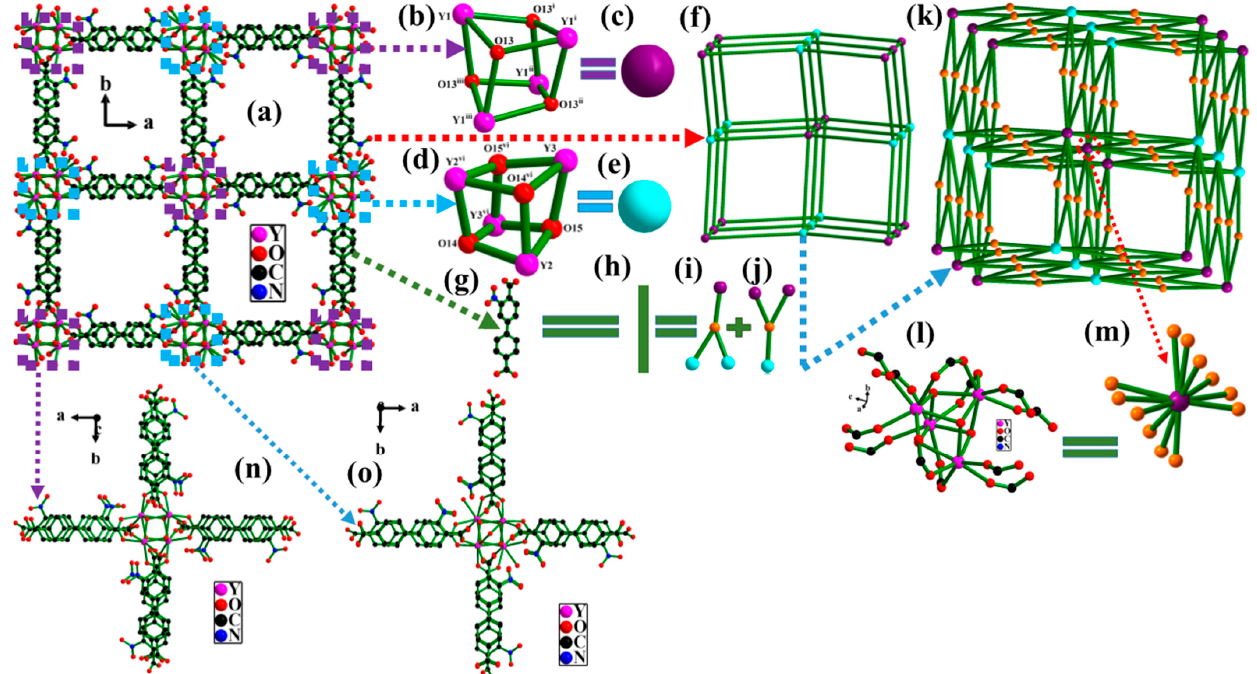
Figure 5. ( a – o ). The simplified schematic diagram of 6-connected pcu net with a Schläfli symbol {4 12 ·6 3 } or 12-connected Au 4 Ho topology with a point (Schläfli) symbol {4 20 ·6 28 ·8 18 }{4 3 } 4 . Topologically, if each {Y 4 O 4 } core serves as a 12-connected node and is linked by 12 nba 2 − ligands, and each nba 2 − chelates or bridges three {Y 4 O 4 } clusters acting as a 3- connected linker (Figure 5). The 3D structure of 1 can be simplified as a 12-connected 2- nodal Au4Ho topology (Figure 5k) with a point (Schläfli) symbol {4 20 ·6 28 ·8 18 }{4 3 } 4 and with